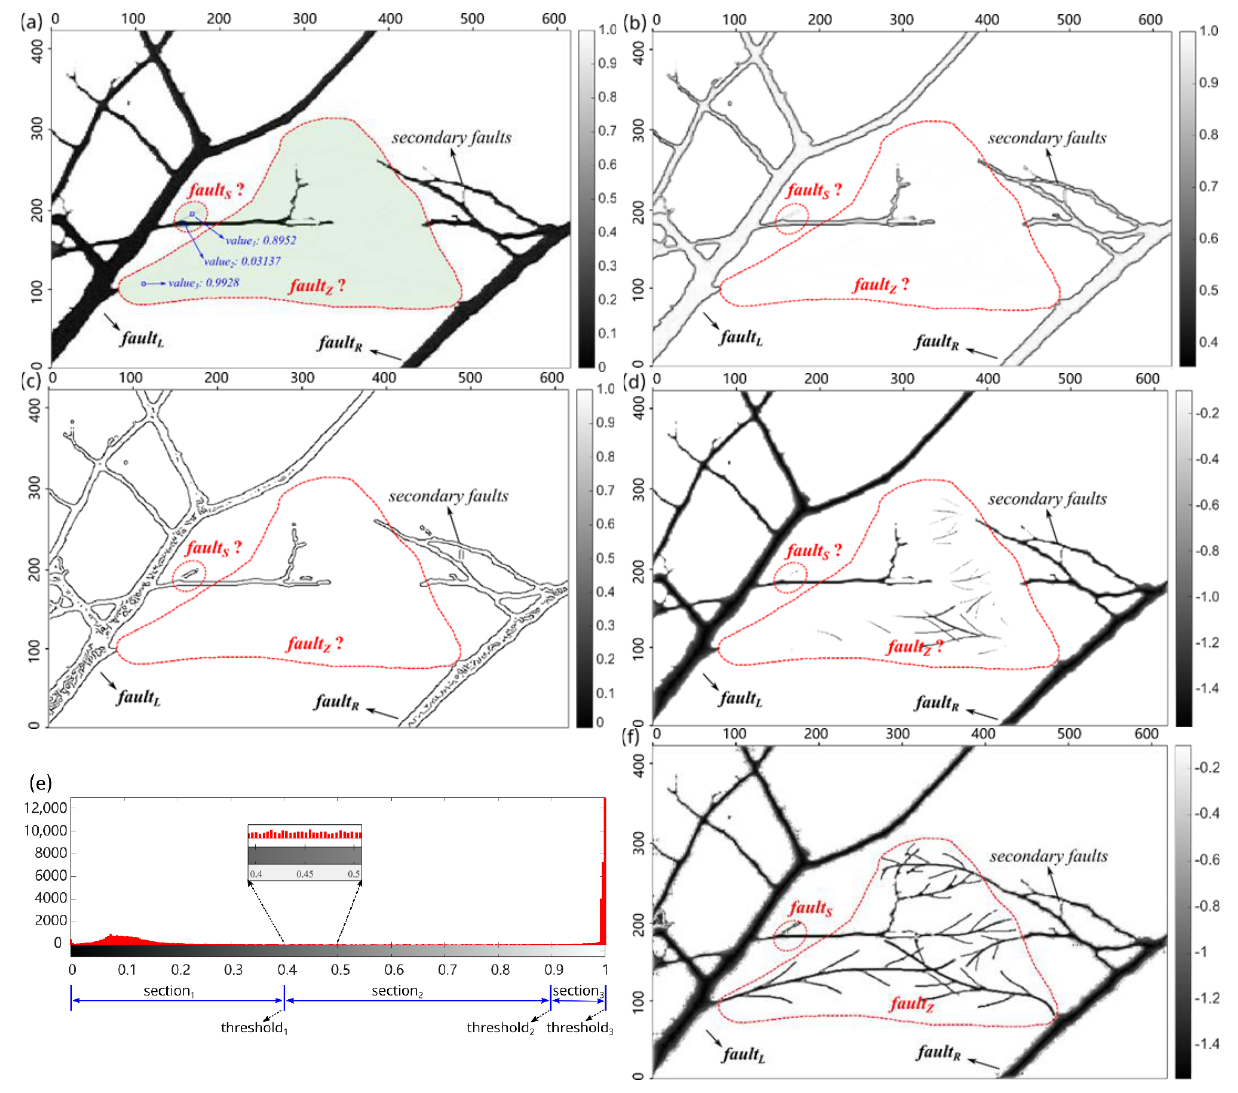
Figure 2. Comparison of coherence property slices (model data) of tiny faults ( a ) and their gradient properties ( b ), Canny boundaries ( c ), PC effects ( d ), the histogram of coherence and three-segment division ( e ), and PC results of segmented strategy and fusion ( f ). The single fault named fault S and the fault zone named fault Z (the green zone in the red dashed line) (shown in Figure 2a) are our main targets. The blue numbers in Figure 2a show the reader the values for the different fracture